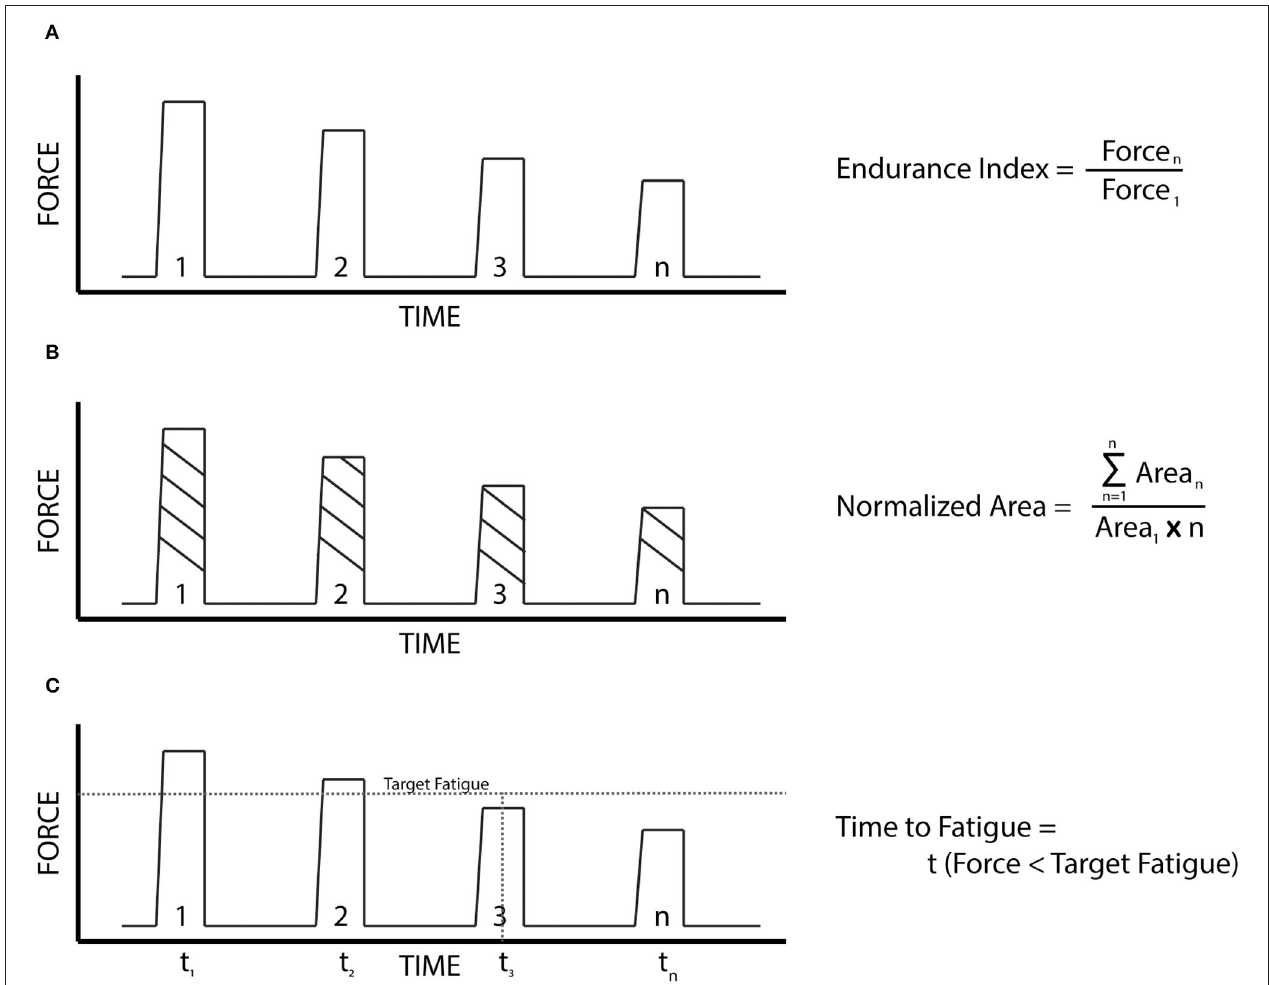
FIGURE 2 | The fatigue metrics. (A) Endurance index: the ratio of the force output at a designated time stamp to that of the initial force output. (B) Normalized force area: The ratio of the total area under the entire force output profile (summation of the area of each contraction times the duration of each contraction), to that of a force output profile if each contraction was identical to the first. (C) Time to fatigue: the time for the force of a contraction to fall below a designated target.